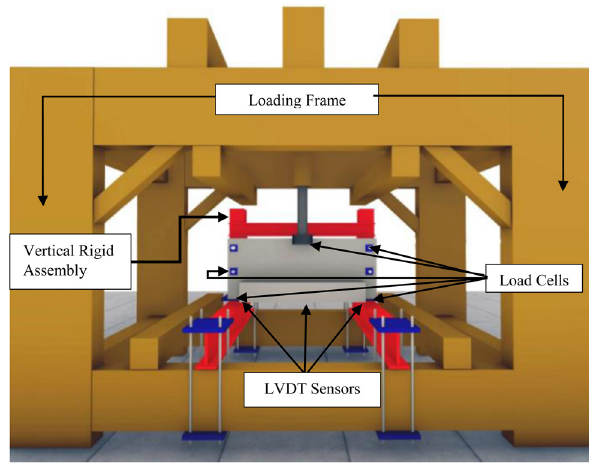
Figure 4: Pro fi le of the test setup.